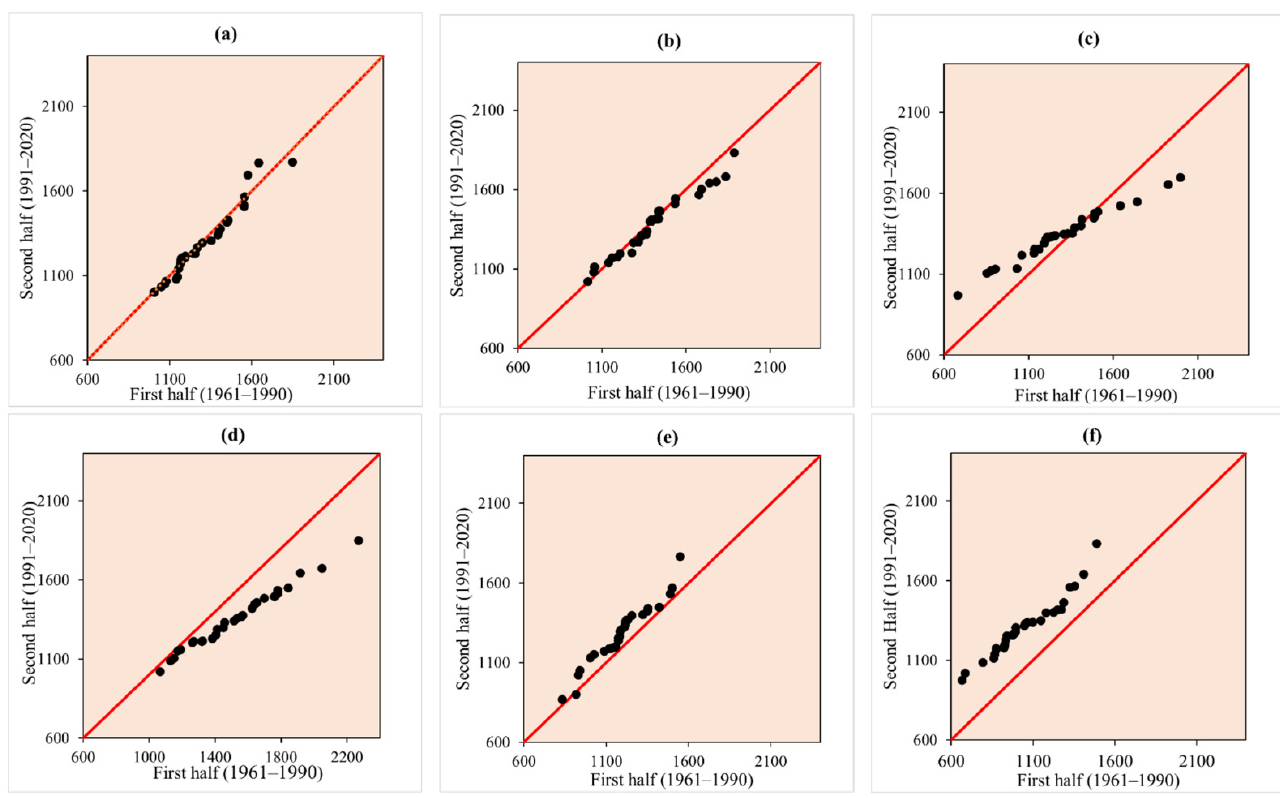
Figure 7. Results of the ITA method applied to the six stations in the Kara River watershed: ( a ) Kara; ( b ) Niamtougou; ( c ) Pagouda; ( d ) Alédjo–Kpéwa; ( e ) Guérin–Kouka; ( f ) Takpamba. ( b ) Niamtougou; ( c ) Pagouda; ( d ) Al é djo–Kp é wa; ( e ) Gu é rin–Kouka; ( f )